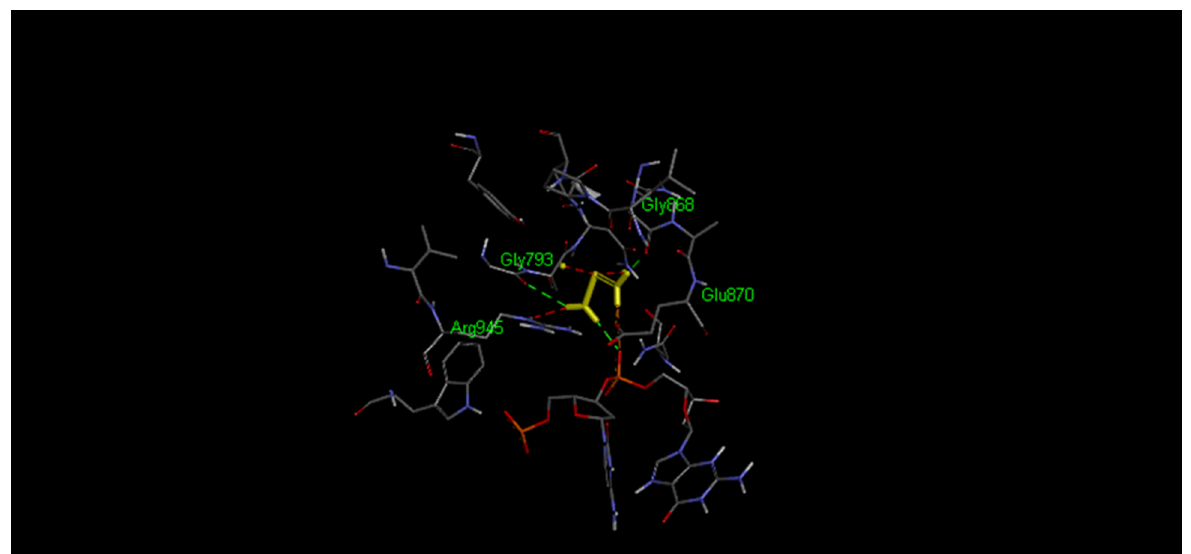
Figure 7. Interaction of cisplatin (experimentally) with the active site of topoisomerase II β (TOP2B) in 3D.